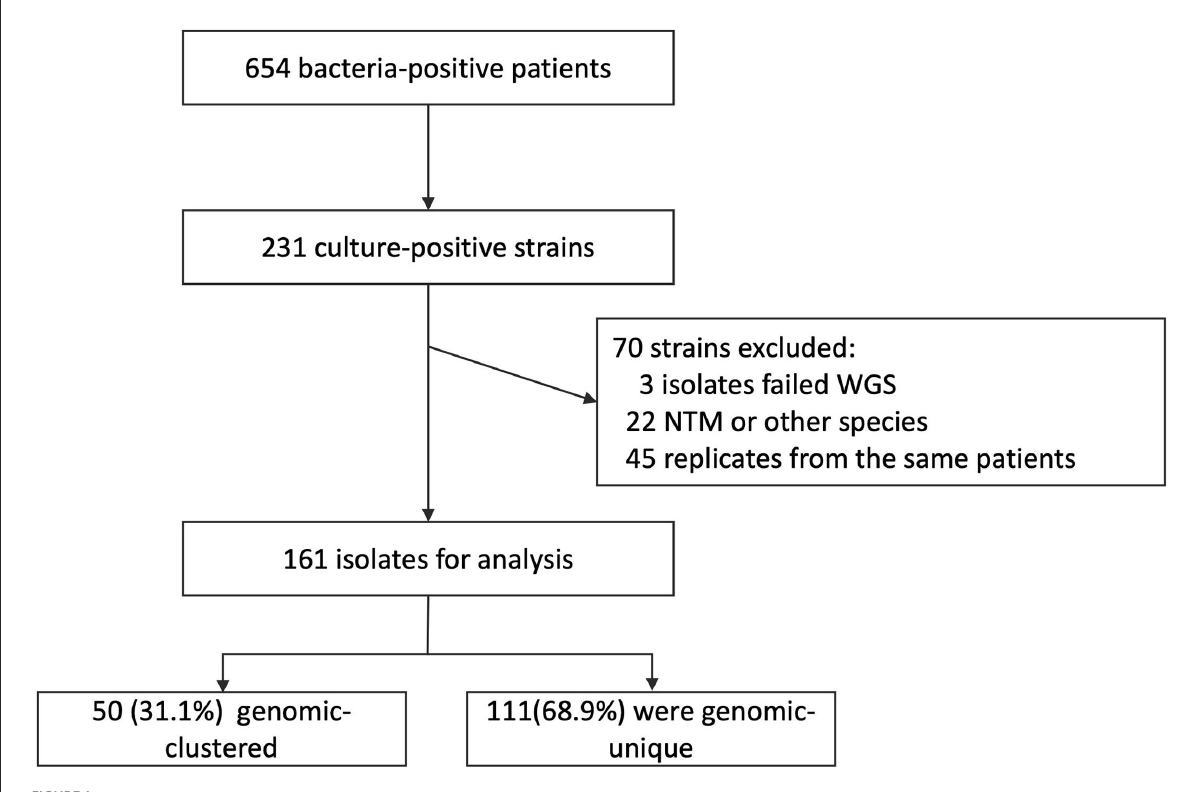
FIGURE1 Patient inclusion flowchart.